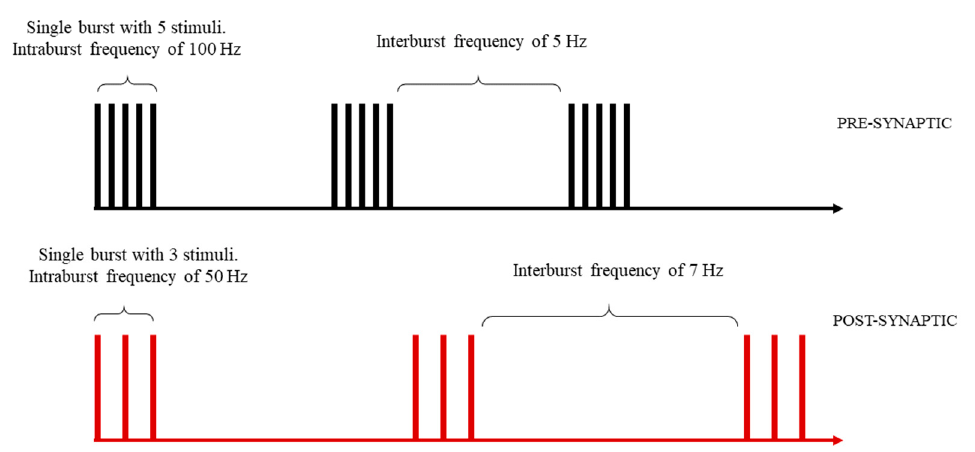
Figure 2. Example scheme of a stimulation pattern. Pre- and post-synaptic stimuli are organized as trains or bursts. Each burst is composed of a sequence of stimuli, delivered at an intra-burst frequency. Inter-burst frequency defines the interval between each burst. Number of stimuli per burst, intra-burst, and inter-burst frequencies can be defined during the stimulation pattern design, for both pre- and post-synaptic patterns.